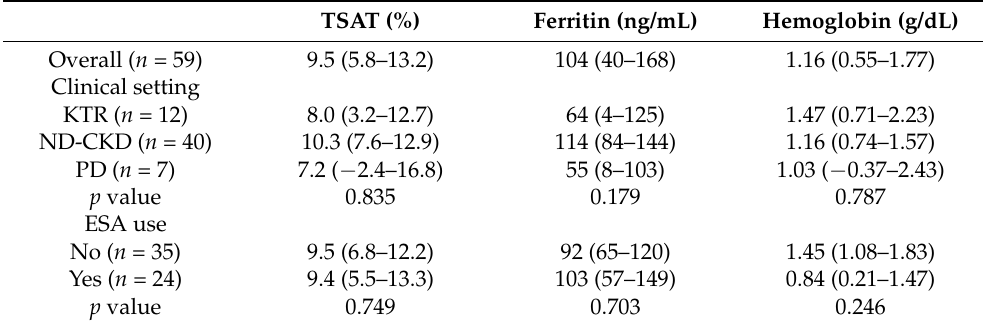
Table 4. Increase of TSAT, ferritin and hemoglobin from baseline to evaluation period (week 20– 24) in the whole cohort and after stratification by either clinical setting or ESA use.